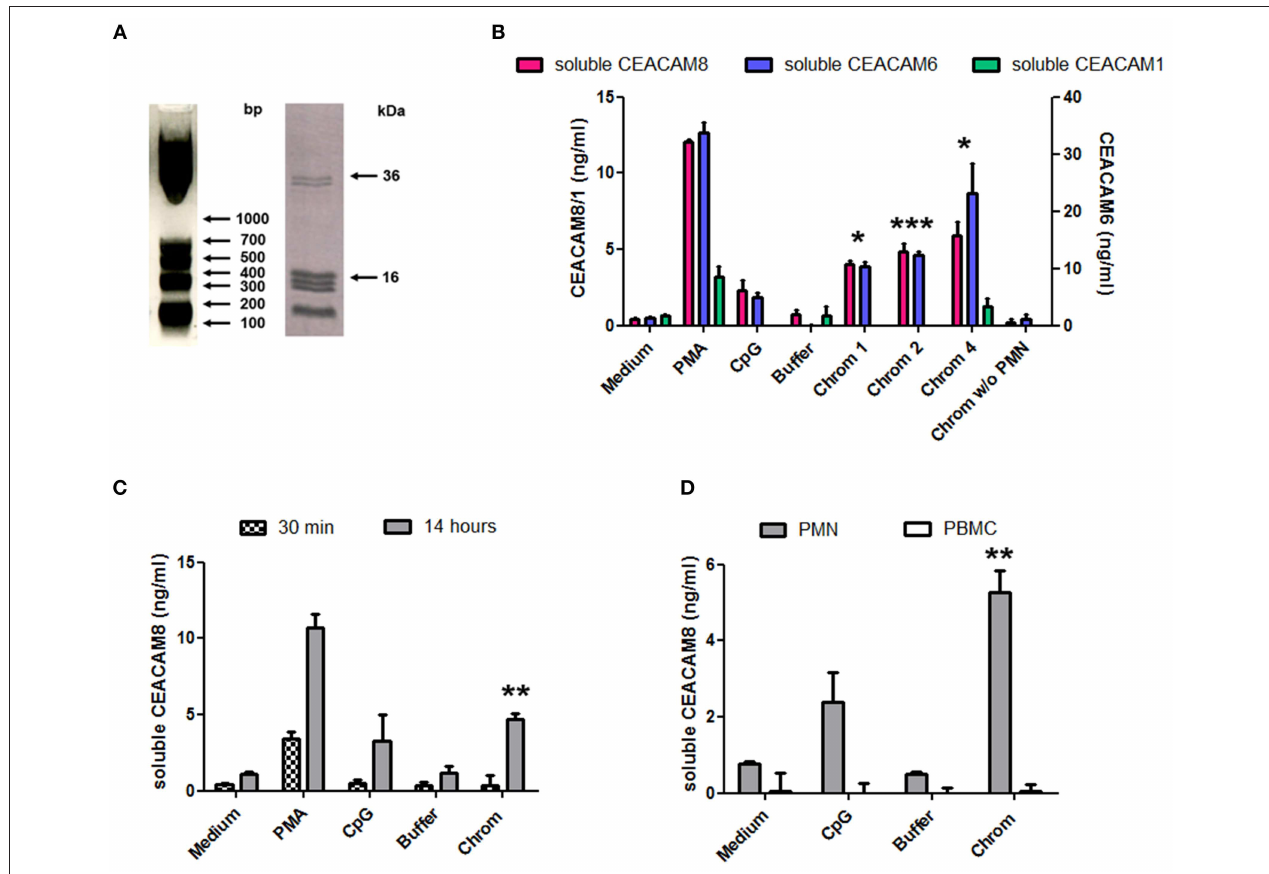
FIGURE 1 | Extracellular chromatin fragments of different sizes trigger the release of soluble CEACAM8 by activated PMN. (A) Chromatin was obtained after nuclease digestion and lysis of nuclei and was then analyzed by 1.5% agarose gel electrophoresis (left) and 18% SDS-PAGE (right). Molecular weight markers are indicated. bp, base pairs. The doublet at ∼ 35 kDa represents histone H1. (B) Freshly isolated human PMN were cultured for 14h at 10 6 cells/ml with different stimuli and the release of soluble CEACAM1, CEACAM6, and CEACAM8 was estimated in the supernatants by ELISA. PMA, phorbol myristate acetate; CpG, oligonucleotide containing unmethylated CpG motifs (TLR9 agonist); buffer, nuclei lysis buffer; Chrom, chromatin (1, 2, 4 indicate concentrations in µ g/ml). As a control, chromatin was incubated without (w/o) PMN. (C) PMN were activated as in (B) for 14h or 30min and secretion of soluble CEACAM8 was estimated (4 µ g/ml chromatin was used). (D) PMN and autologous PBMC were cultured and activated (4 µ g/ml chromatin) in parallel for 14h and then secretion of soluble CEACAM8 was determined. Shown is one representative experiment of seven independent experiments using different donors and different chromatin preparations. Mean and SD of triplicates are shown. * p < 0.05; ** p < 0.01; *** p < 0.001 for soluble CEACAM8/6 concentrations after culture with chromatin vs. the purification